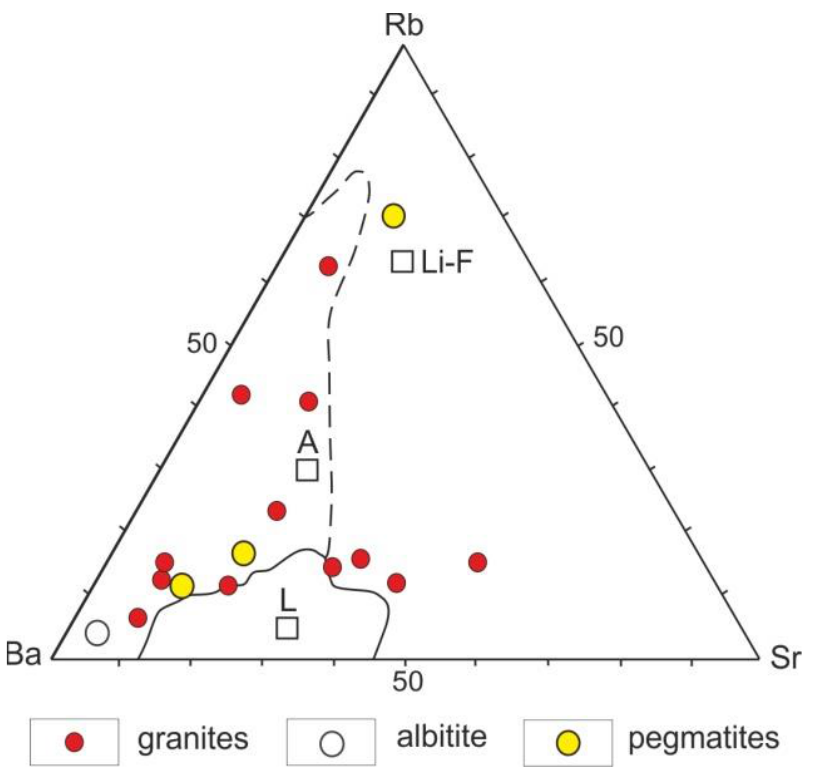
Figure 16. Ba – Rb – Sr diagram for rocks of the Somnitelnyi massif and Tommot deposit. Fields in the Figure 16. Ba–Rb–Sr diagram for rocks of the Somnitelnyi massif and Tommot deposit. Fields diagram [65]: A — rare-metal alkaline granites, L — latitic granites, Li-F — plumasitic lithium-fluoride granites.